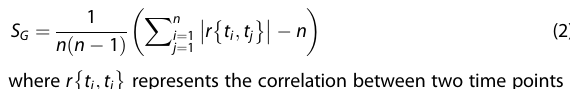
Table 1. Clinical